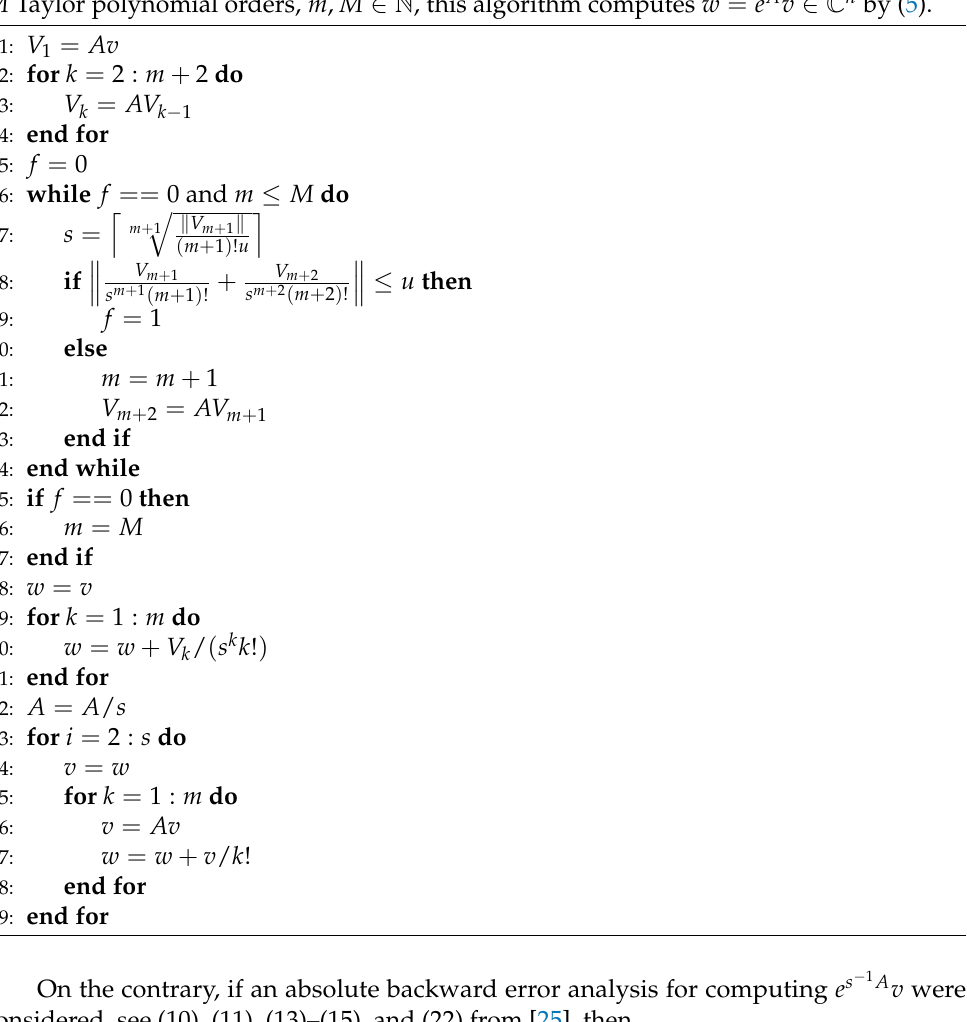
Algorithm 1 Given a matrix A ∈ C n × n , a vector v ∈ C n , and minimum m and maximum M Taylor polynomial orders, m , M ∈ N , this algorithm computes w = e A v ∈ C n by